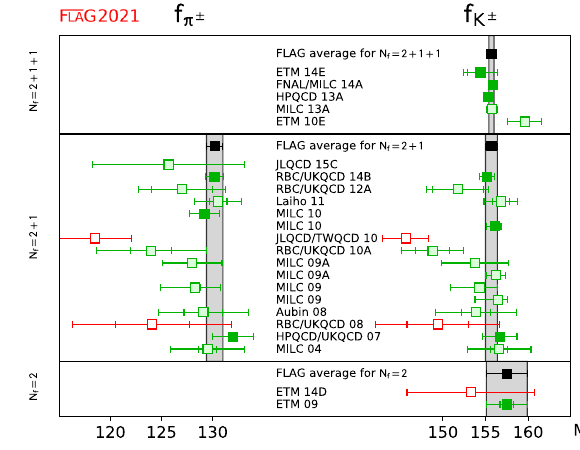
Fig. 13 Values of f π and f K . The black squares and grey bands indicate our averages (85) and